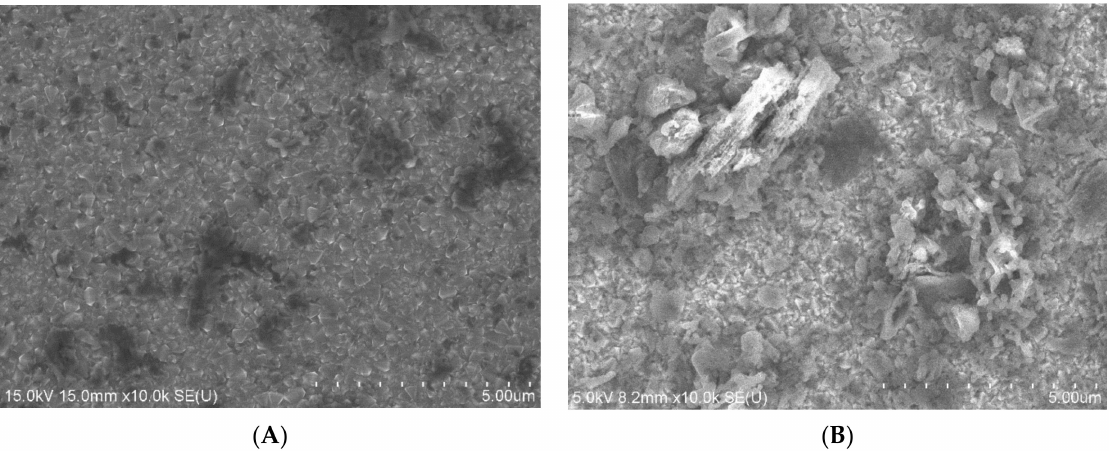
Figure 3. SEM images of ( A ) FTO glass substrate and ( B ) US-treated exfoliated g-C 3 N 4 particles (0.050 mg cm − 2 ) on FTO glass deposited by electrophoresis from the stable part of a suspension aged